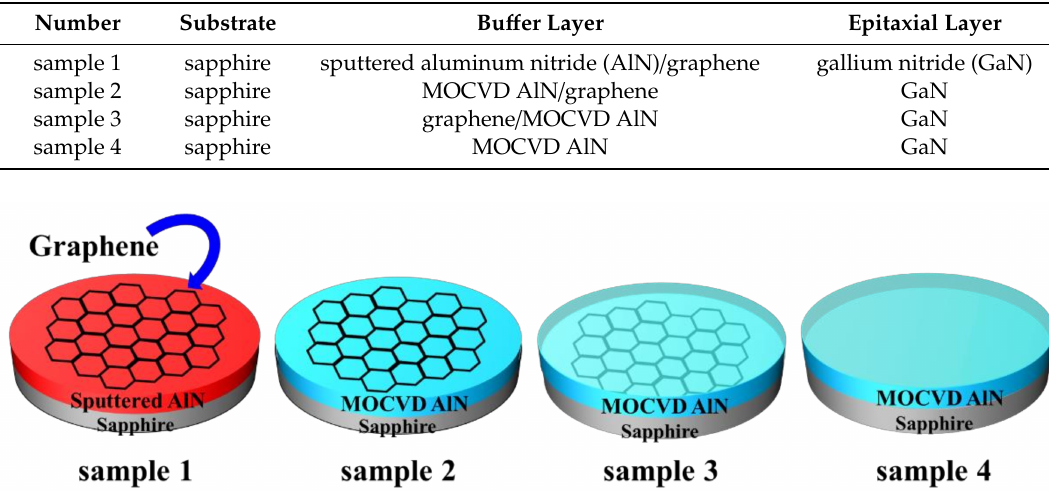
Table 1. Schematic table of bu ff er layer structure information of four samples in this work.